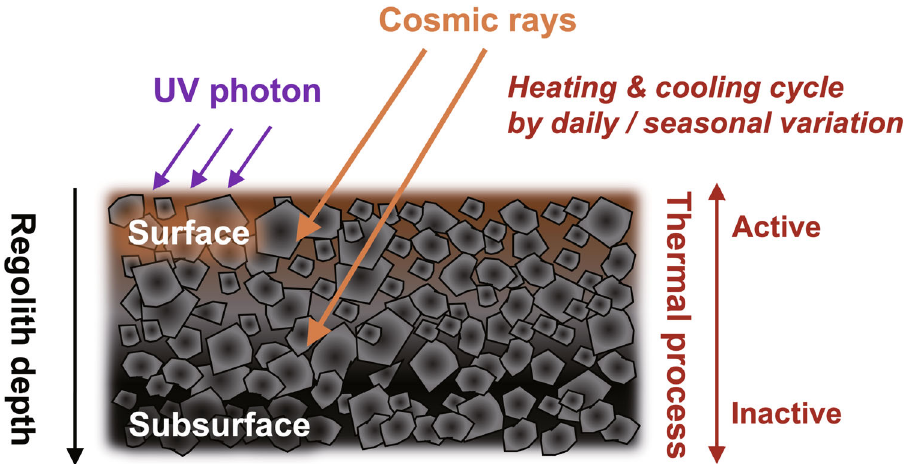
respectively, and the length of each line is a qualitative model of the penetration depthintotheregolith.Kitazatoetal. 19 estimatedthatthecurrentseasonalthermal skin depth of Ryugu is up to ~1.1metre by the model simulation, whereas the total accumulated heat storage within the daily thermal skin depth is estimated to be ~ few centimeter scale below the surface layer 57